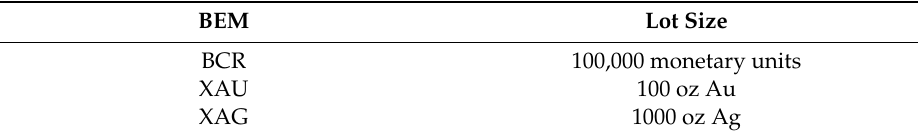
Table 1. Lot definitions for main